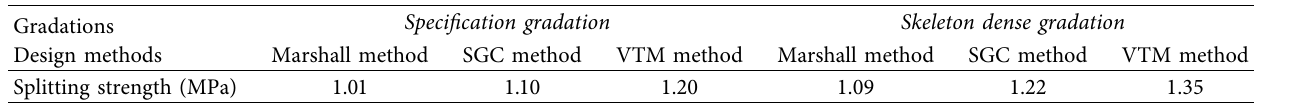
Figure 5: The failure process of SMA-13 mixture samples. (a) Full stress stage. (b) Fatigue crack initiating stage. (c) Fatigue crack expansion stage. (d) Sample failure stage. Table 8: Splitting strength of SMA-13 mixture.